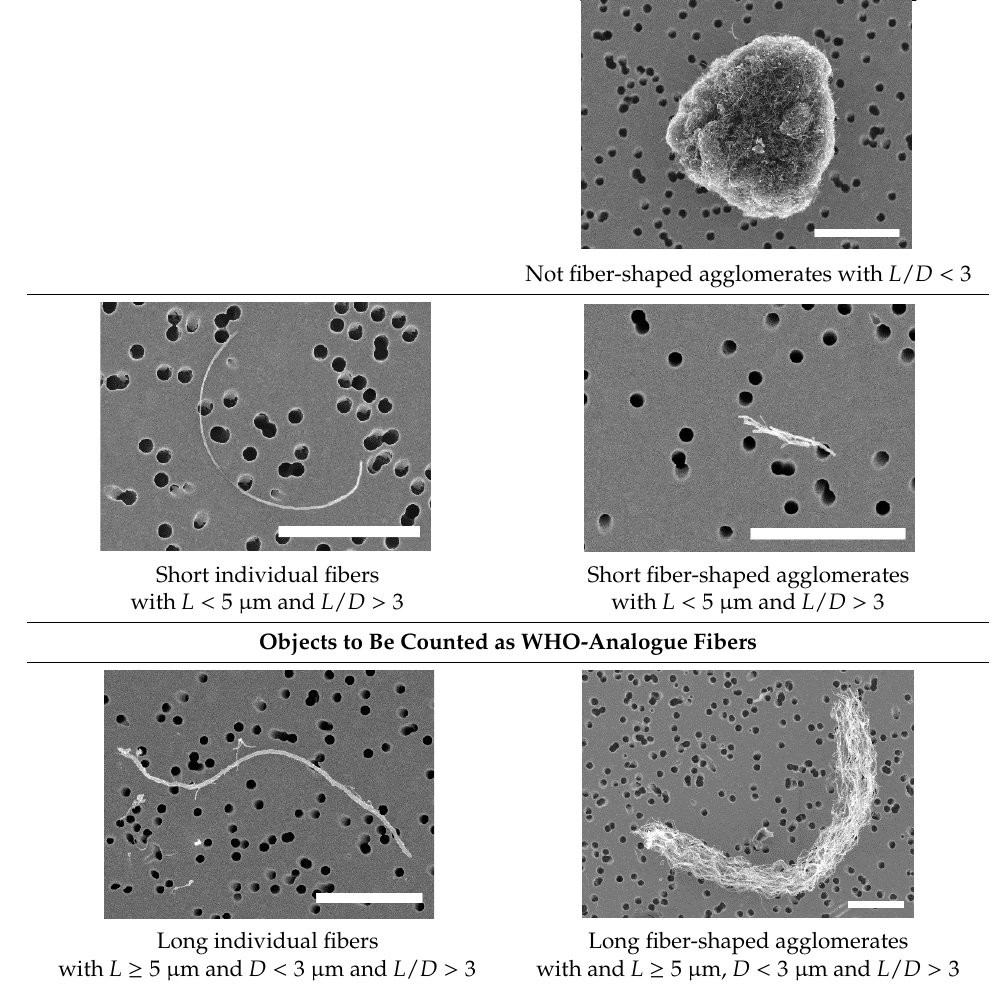
Table 5. Categories for categorizing respirable particles according to morphology, exemplified by example images. The length of the scale bar is 2 µ m.